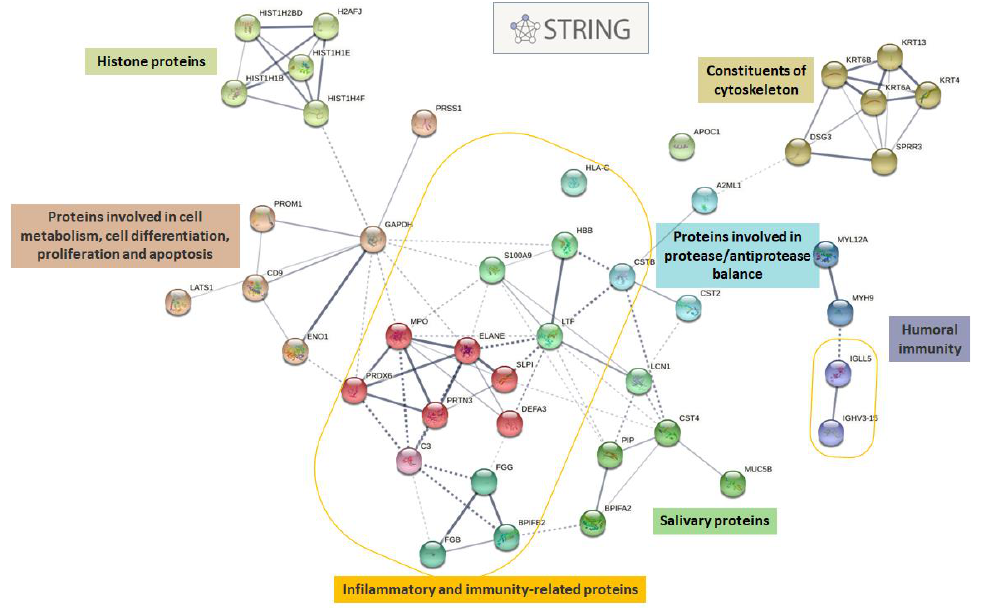
Figure 2. STRING protein – protein interaction networks of concordant differentially expressed proteins in pSS and SSA+ patients. The network shows the potential interactions of proteins inferred from experiments, databases, text mining, and co-expression with medium confidence. Different clusters, generated through the MCL clustering method, are indicated by color and the thickness of the connecting lines indicates the confidence of interactions.